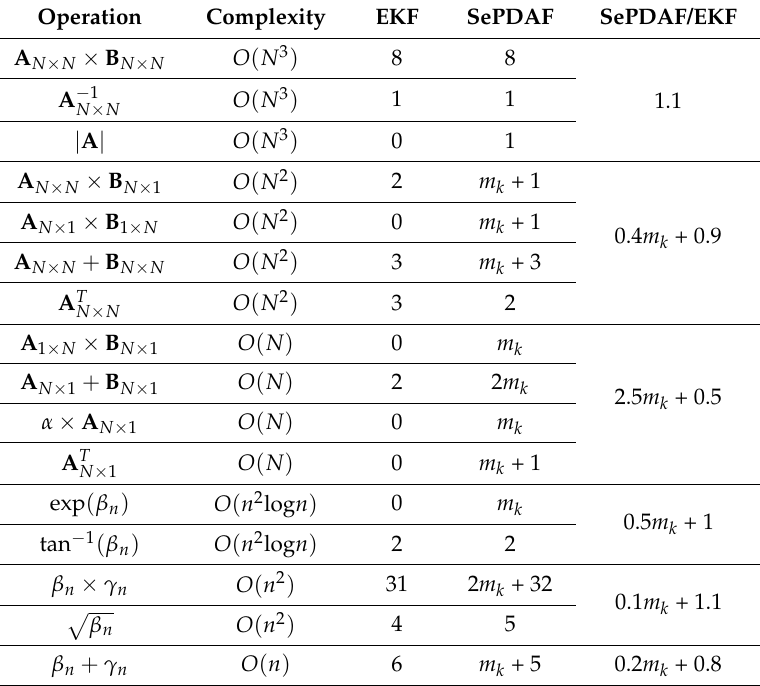
Table 1. Computational complexity of EKF and